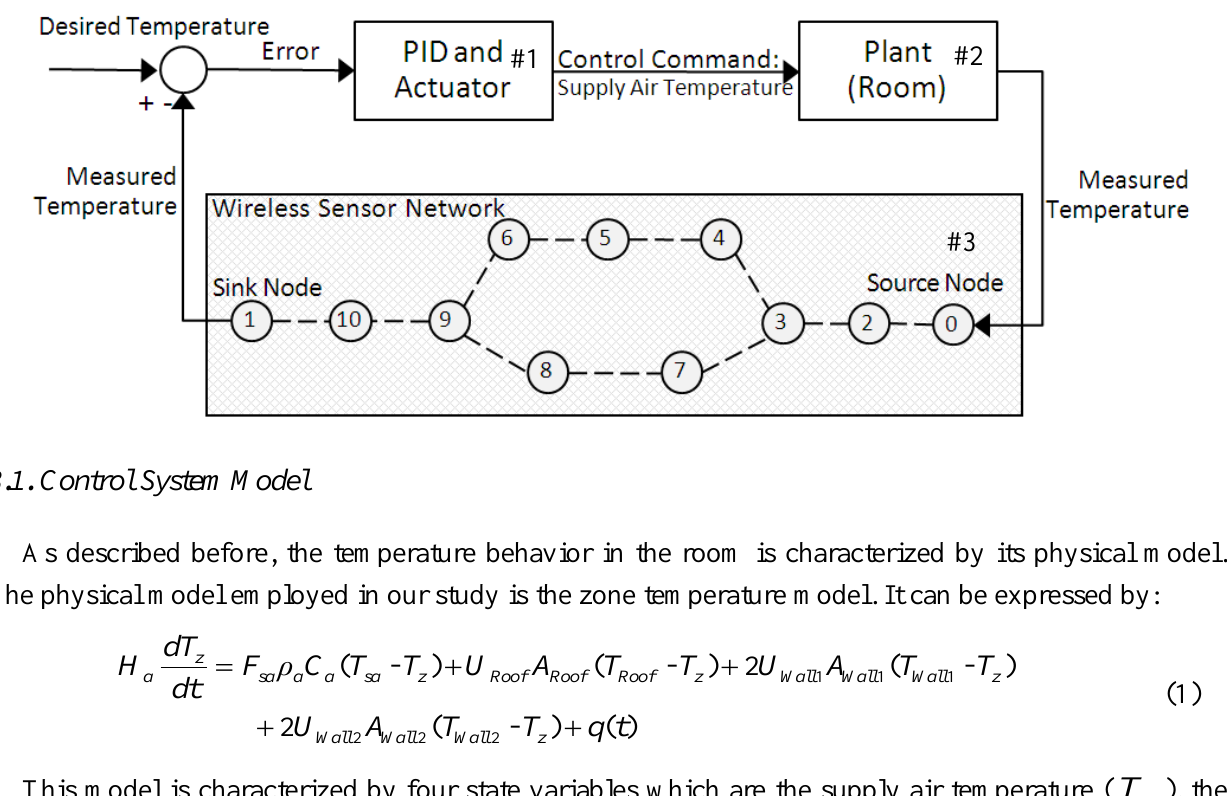
Figure 1. Building-temperature control